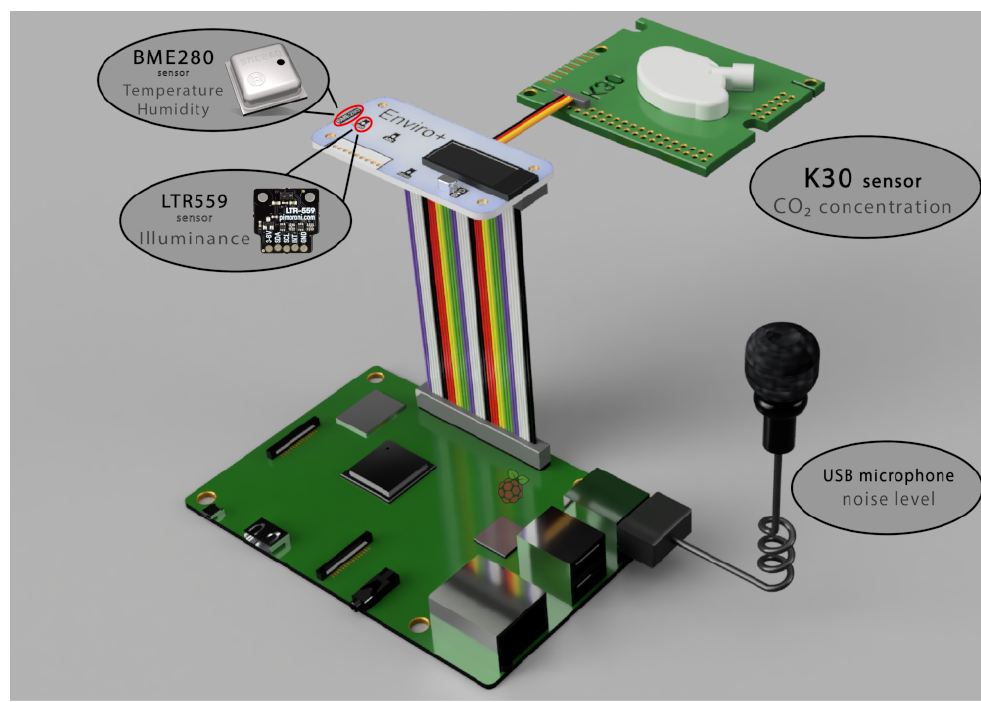
Figure 2. Sensors adopted by the